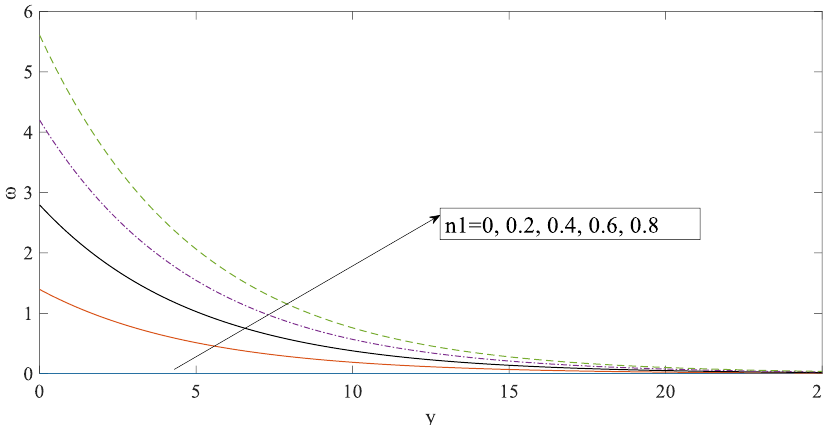
Figure 5. Angular Velocity profile against displacement variable y for Nr=0.1, Pr=5, M=2, b=0.5, Sc=2,